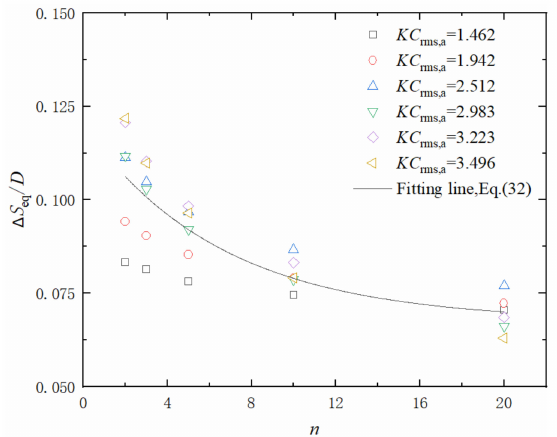
Figure 19. The fitting line between ∆ S (cid:48) and n